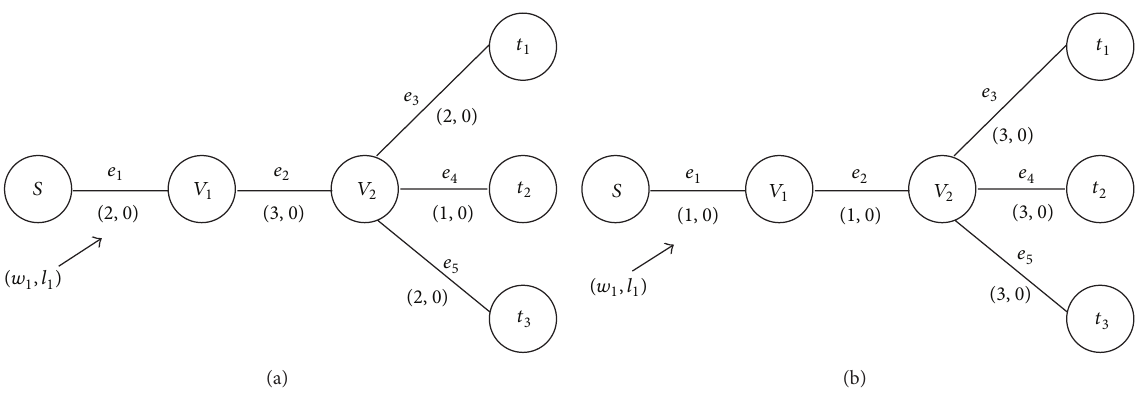
Figure 2: Examples of arborescent networks with a single source.